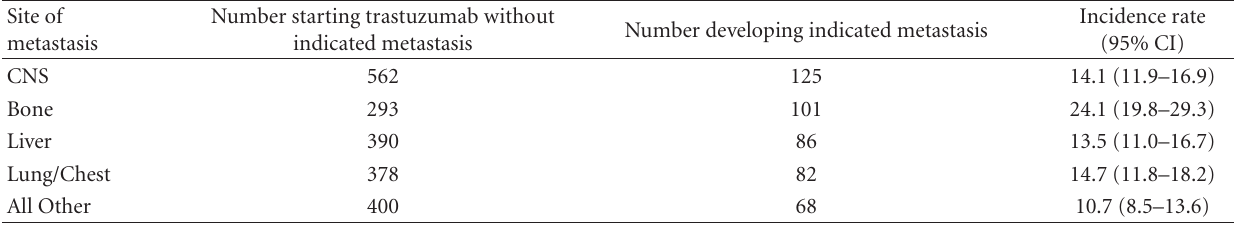
Table 2: Incidence rates for metastases by